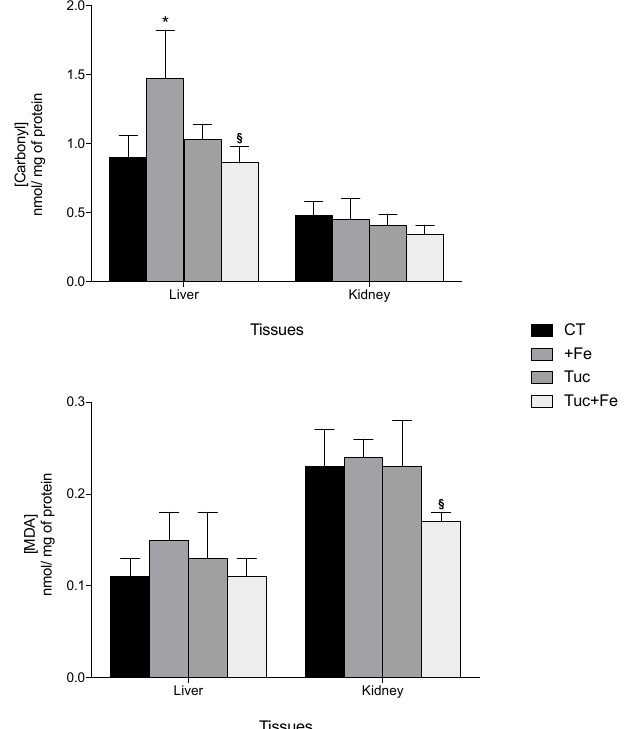
Figure 2. Effect of iron and/or tucum-do-cerrado intake in oxidative damage in the liver and in the kidney of adult rats treated for 12 weeks. Data correspond to average ± standard deviation ( n = 6). * Statistical differences compared to CT group ( p < 0.05). § Statistical differences compared to +Fe group ( p < 0.05). MDA, malondialdehyde.